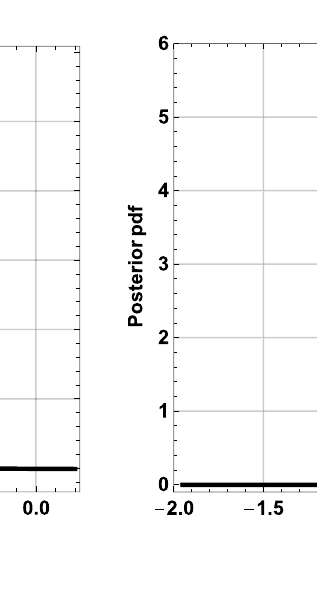
μ = − C μ (second 9 10